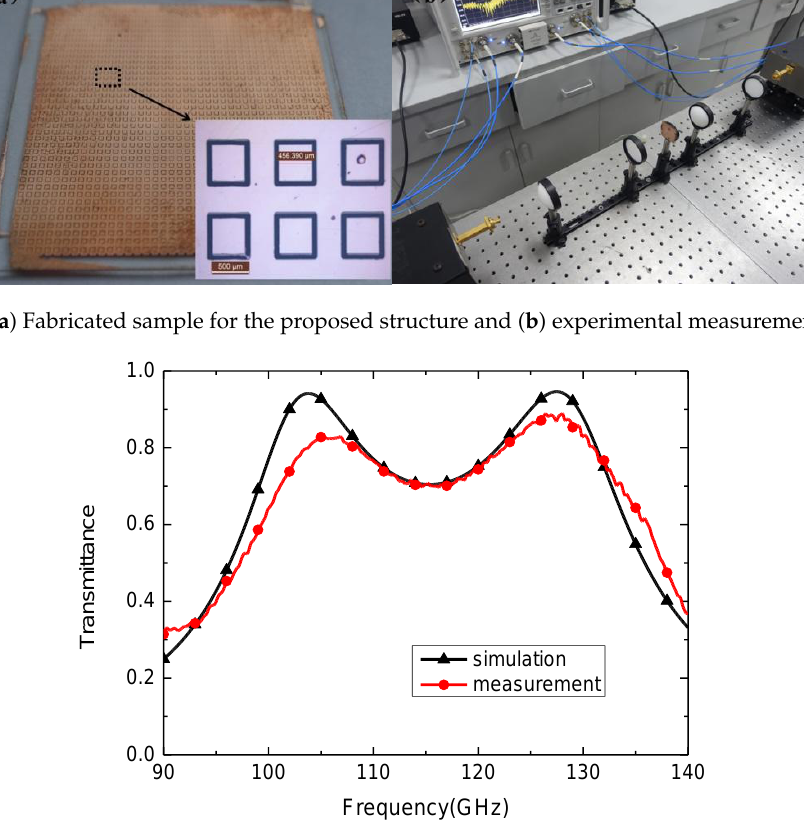
Figure 7. Simulation and measured transmittance of the proposed structure in the F-band.